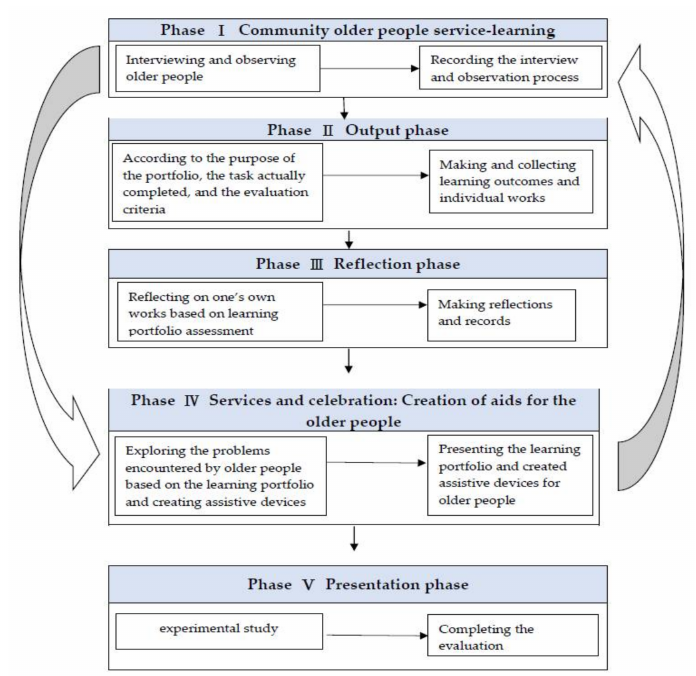
Figure 2. Curriculum stages for the experimental